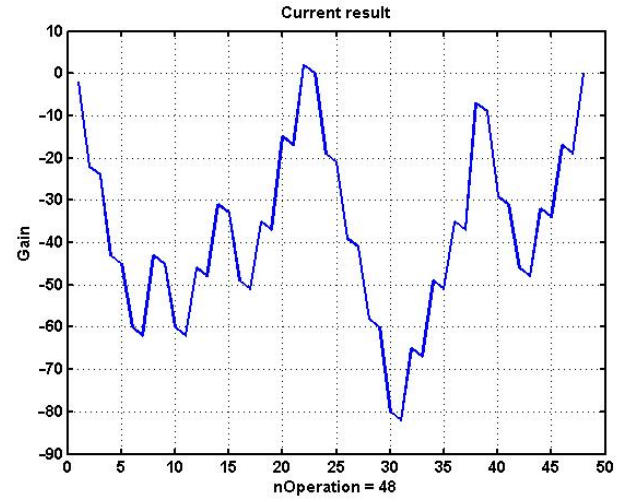
Figure 2. Performance of the CSF strategy for example in Figure 1.